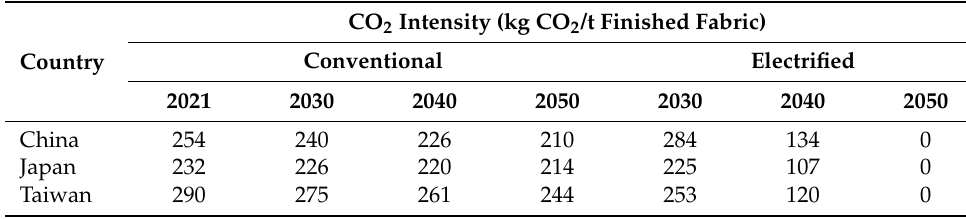
Table 12. The CO 2 intensity of the conventional and electrified drying process. CO 2 Intensity (kg CO 2 /t Finished Fabric) Conventional Country